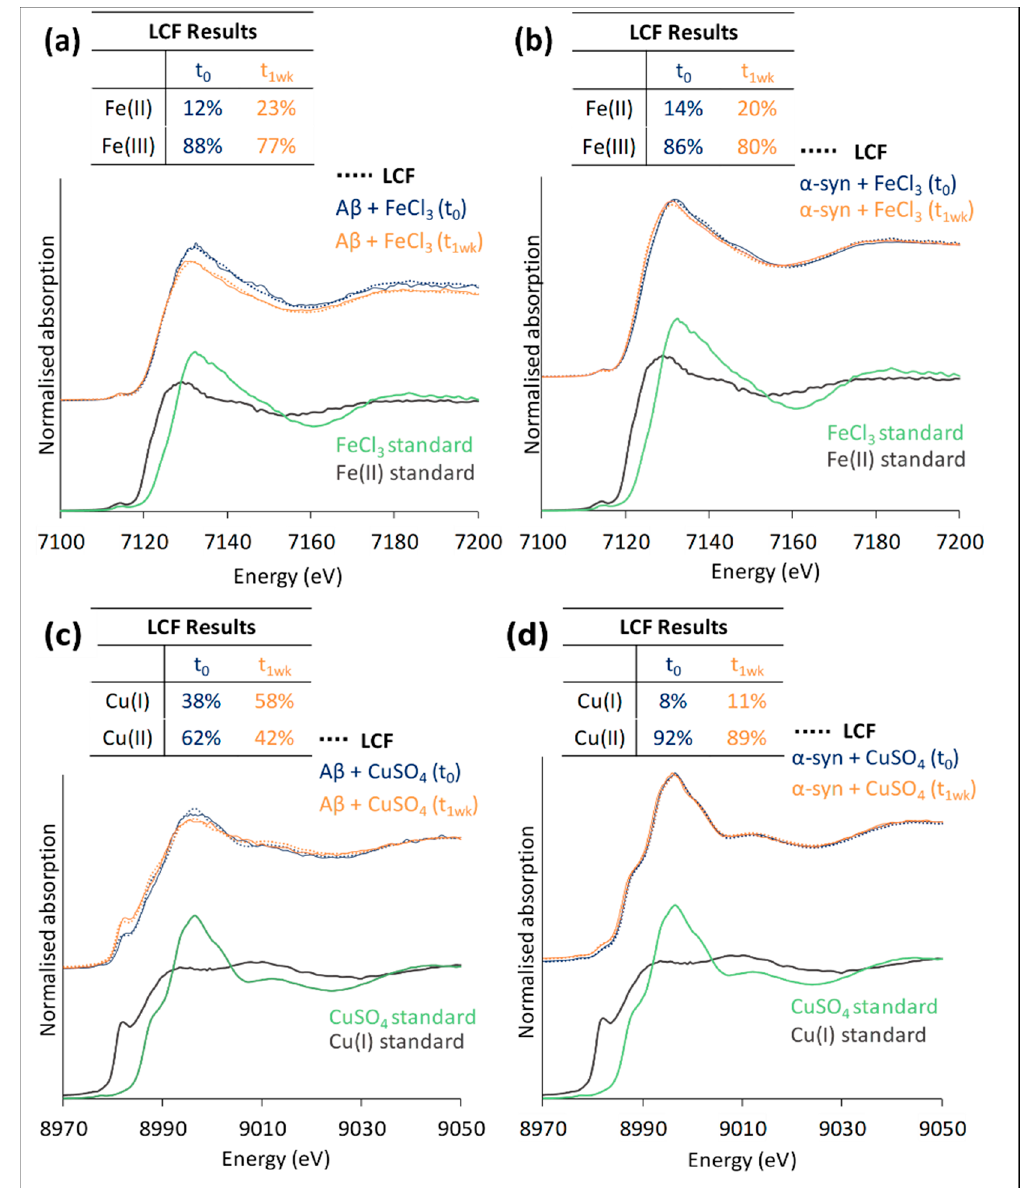
Figure 2. XANES traces showing the effect of 1 week’s incubation on metal oxidation states. ( a ) A β and ( b ) α -syn on the oxidation state of Fe, and ( c ) A β and ( d ) α -syn on the oxidation state of Cu. Ferric and ferrous standards (Fe(III)Cl 3 and [Fe(II) + 1,10-phenanthroline], respectively) were used for linear combination fitting (LCF) of the spectra in ( a ) and ( b ), and cupric and cuprous standards (Cu(II)SO 4 ) and [Cu(I)-glutathione] were used for ( c ) and ( d ); the results from the LCF are tabulated in each panel; below the experimentally-acquired XANES spectra are the reference standards used to fit them for each time point ( a )–( d ). In ( a ) and ( b ), inclusion of a small contribution from iron(III) ammonium citrate in the LCF resulted in improved quality of fit. χ 2 values are as follows for t 0 and t 1wk fits, respectively: ( a ) 0.06, 0.03; ( b ) 0.04, 0.02; ( c ) 0.07, 0.06; ( d ) 0.002, 0.04. Traces for metal-peptide incubations are vertically offset from the reference standards for clarity.